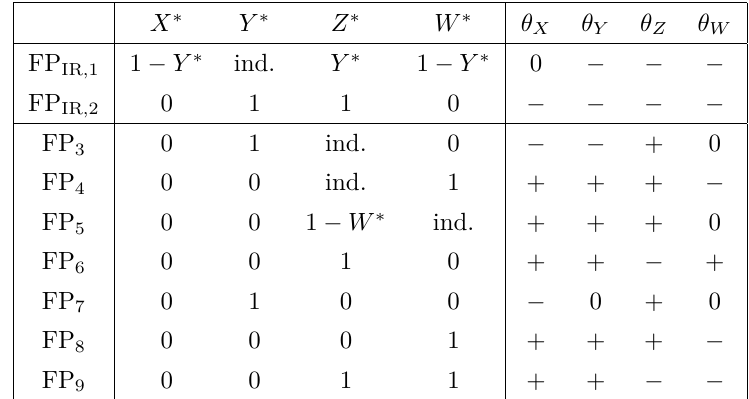
Table 3. The fixed points of the system (A.15)–(A.18) with y ∗ Yukawa couplings set at zero. In the right-hand side box the signs of the relative critical exponents are given. The abbreviation “ind.” indicates an indeterminate value of the corresponding mixing